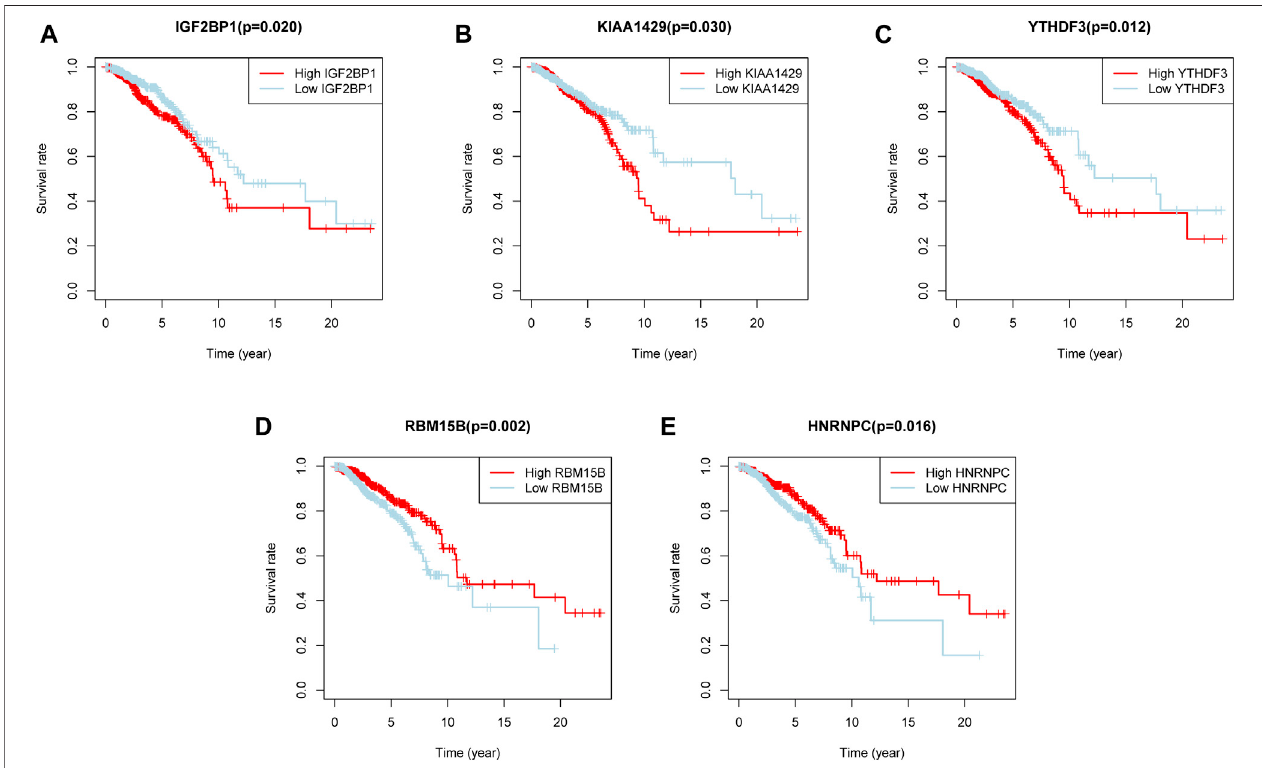
FIGURE 3 | Five m6A regulators were associated with overall survival. (A – E) The overall survival curves of m6A regulators. p < 0.05 were considered statistical signi fi